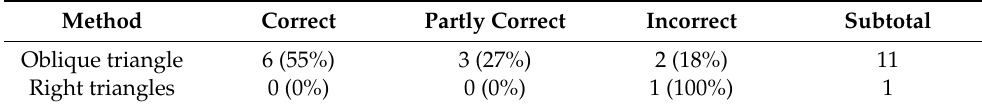
Table 8. Effect of different strategies on the performances in solving the second word problem.